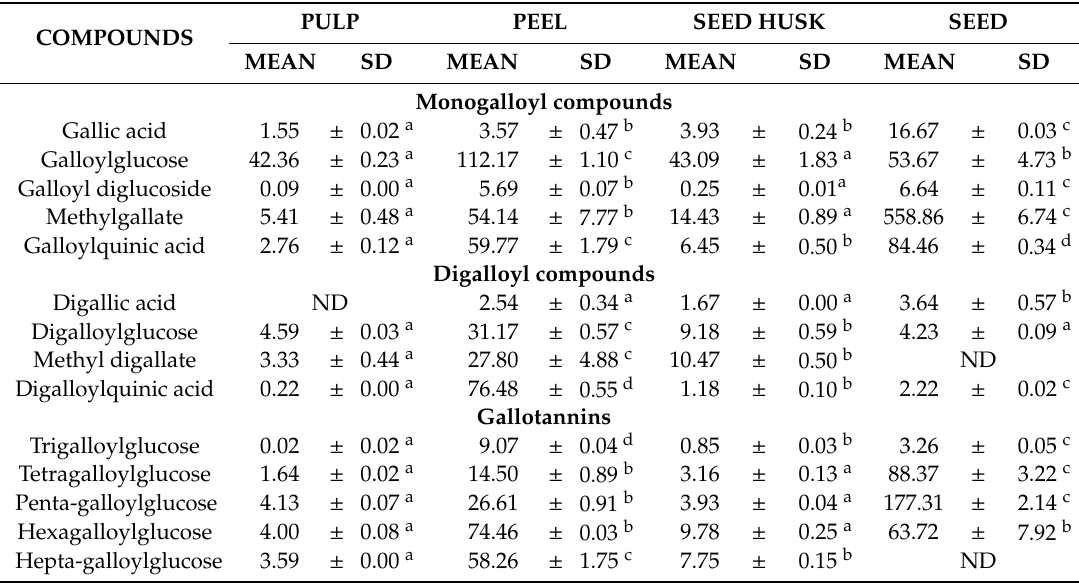
Table 1. Mean concentration of gallic acid derivative compounds from di ff erent parts of Keitt mango variety at optimum maturation stage expressed as mg / 100 g dry matter .